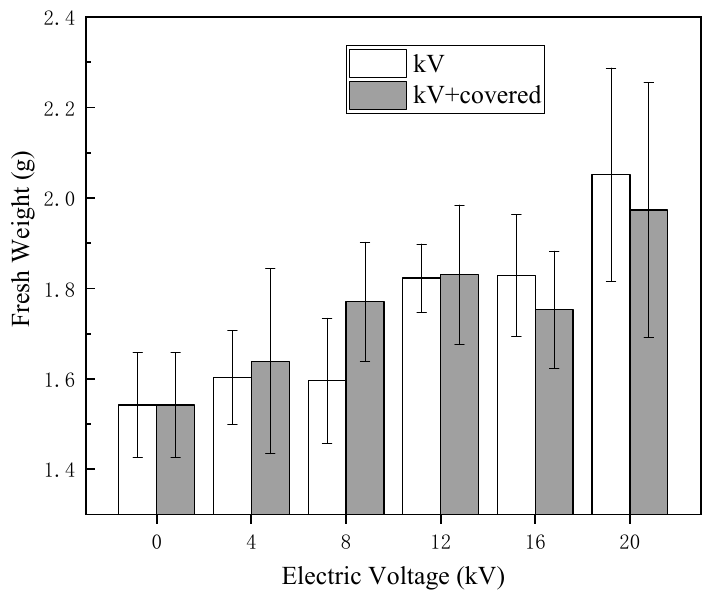
Figure 6. Changes in fresh weight of naked oat seedlings after HVEF treatment.